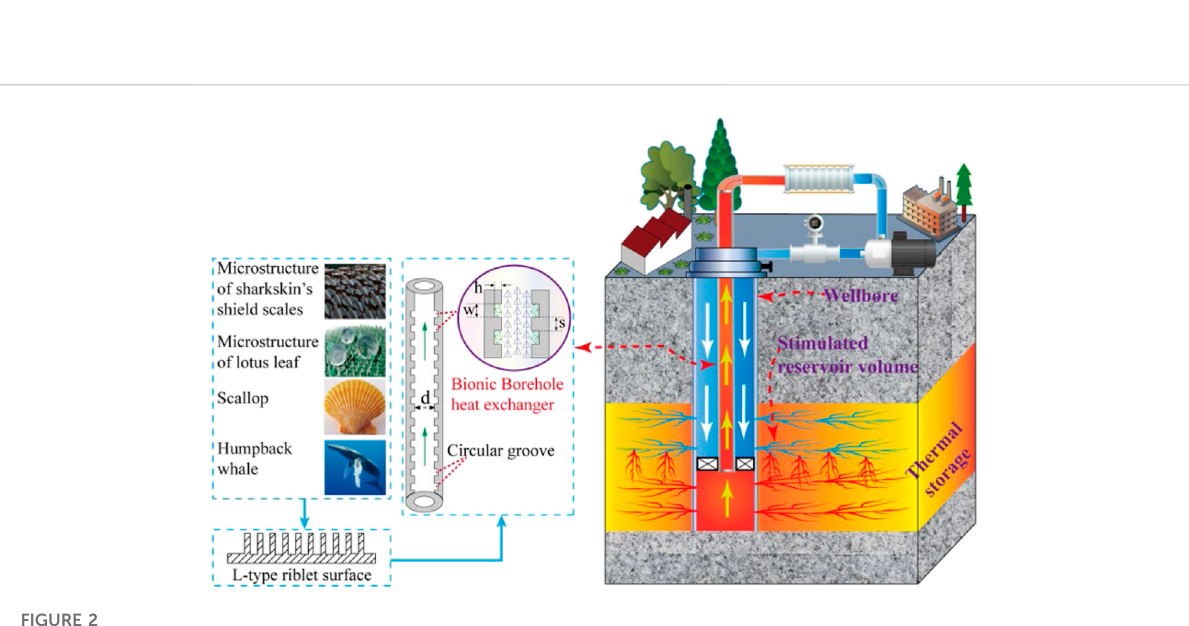
FIGURE 2 Conceptual illustration of a